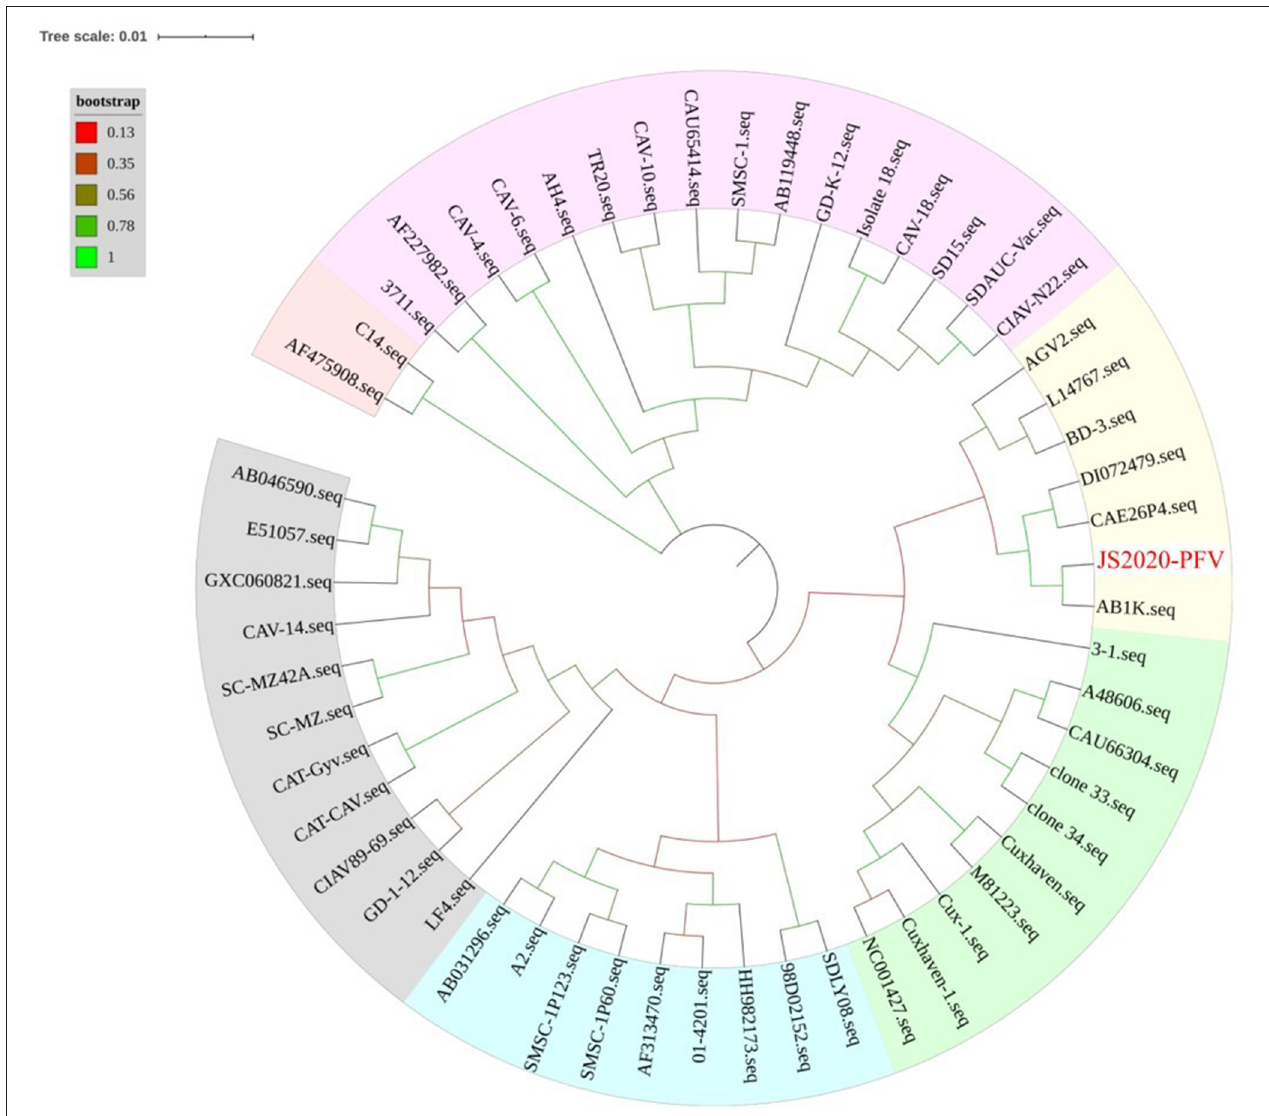
FIGURE 3 | Phylogenetic tree of full-length viral genome of JS2020-PFV and reference strains. The isolated strain in this study has been highlighted in red. The tree was constructed by the maximum likelihood method with 1,000 bootstrap replicates using MEGA 5.0.